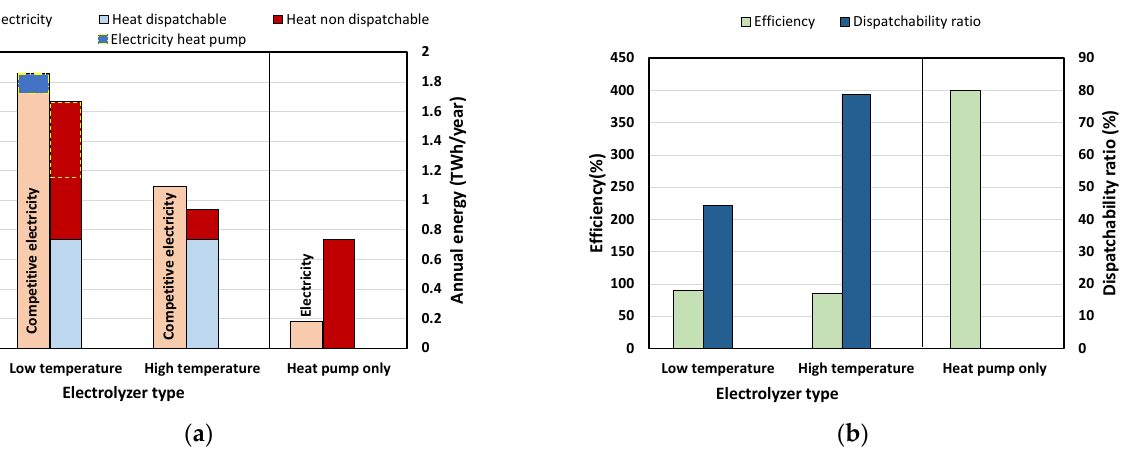
Figure 8. Energetic performances of the investigated process for the two types of electrolyzer units considered. For comparison, the estimated performance of an equivalent DH heat pump system is included (note that against the TCES process, heat pump only does not consume exclusively competitive electricity and therefore is indicated as “electricity”) ( a ) Annual net energy flows of the proposed scheme for the two types of electrolyzers analyzed. The dispatchable heat is generated in the discharging section, while the nondispatchable heat is generated in the charging section. The amount of nondispatchable heat that can be recovered if a heat pump is in place is marked within a dashed yellow line ( b ) Dispatchability ratios and energy efficiencies (electricity to heat) of the proposed scheme for the two types of electrolyzers analyzed. Note that the dispatchability ratio of heat pump only is 0.